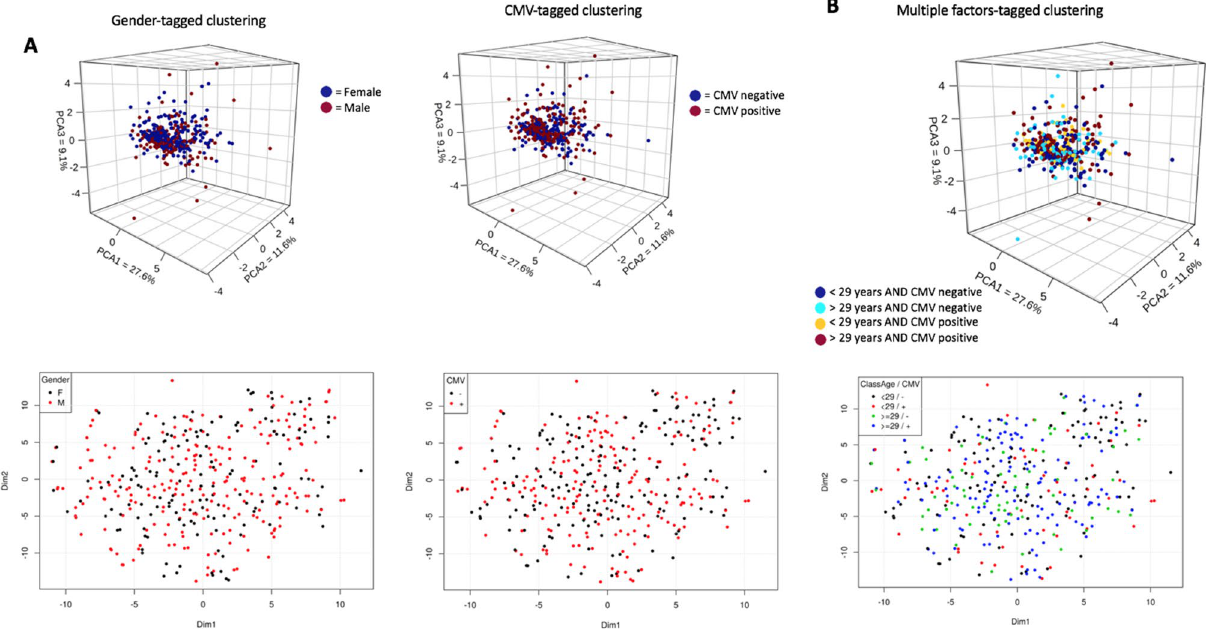
Figure 5. Three-dimensional PCAs of the GEOCODE study cohort with intrinsic and extrinsic factors. (A) Three dimensional PCAs and tSNE of the GEOCODE study cohort are depicted with tagged individuals according to age, gender, EBV/CMV status separately. (B ) Three-dimensional PCA and tSNE of the GEOCODE study cohort is depicted with tagged individuals according to combination of the age and CMV factors. Graphs were performed using R Software version